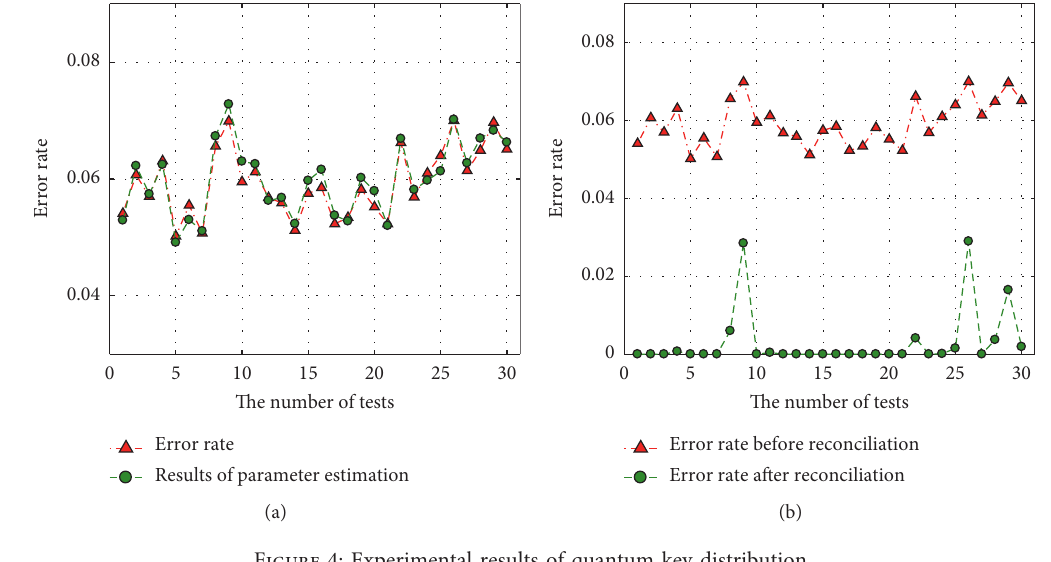
Figure 4: Experimental results of quantum key